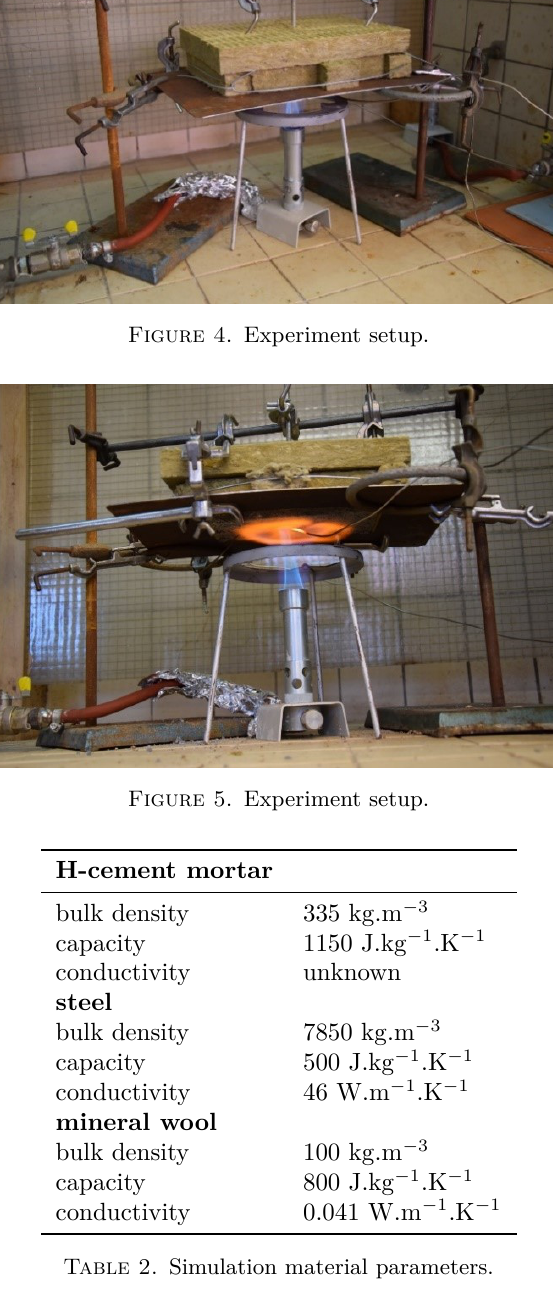
Figure 3. Experiment setup.